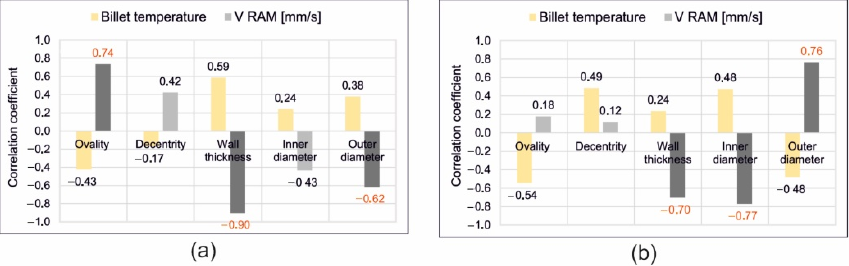
Figure 21. Results of statistical correlation analysis for optically scanned tubes of Ø50 × 2 mm extruded from 7021 alloy through porthole dies for different billet temperatures and different ram speeds, a ) die 1, b ) die 2.